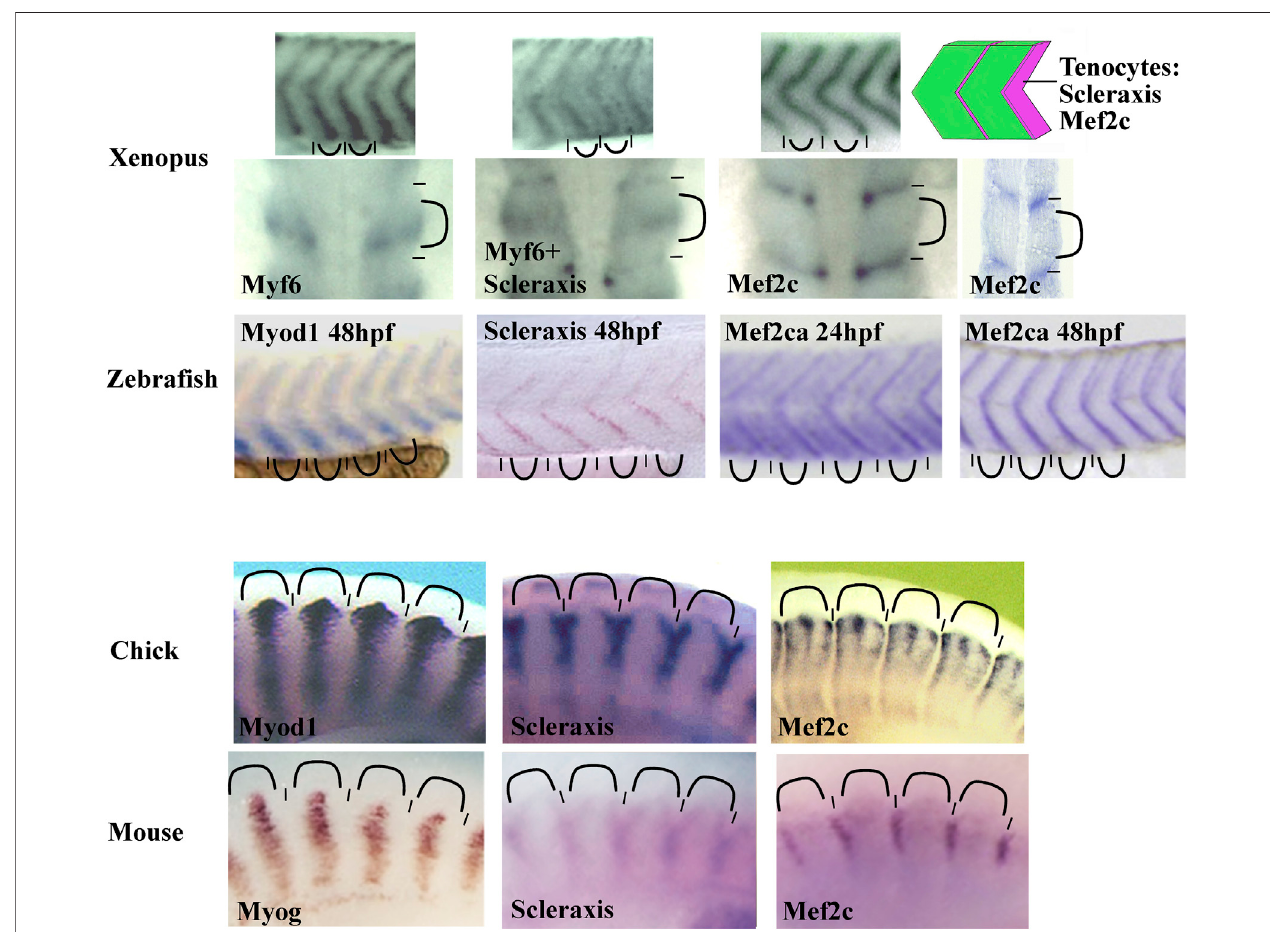
FIGURE5| ComparisonofthesomiticMef2cmRNAexpression betweenzebra fi sh, Xenopus ,chick,andmouse.TheMef2cexpressionisconservedinvertebrate somites. The staining is intense in intersomitic region corresponding to the syndetomewhere the tenocytes differentiate (schematic on the top right corner). In chick, the staining is reduced to muscle-associated tissue. The Mef2c expression is compared with both Scleraxis (syndetome marker) and Myod1, Myf6, or Myogenin (myotome markers).The somitic blocks are indicated bycurved lines and the intersomitic regions byshort lines. Forzebra fi sh, the Mef2ca expression at 24 and 48 hpf (hours post fertilization). The probe is indicated in each image. All images are lateral views except the second row for Xenopus where the fi rst three images at the left are dorsal views and the forth image at the right is a front view. Figure is composed of images from ISH database of ZFIN for zebra fi sh (z fi n.org), Geisha for chick (geisha.arizona. edu) and Embrys for mouse